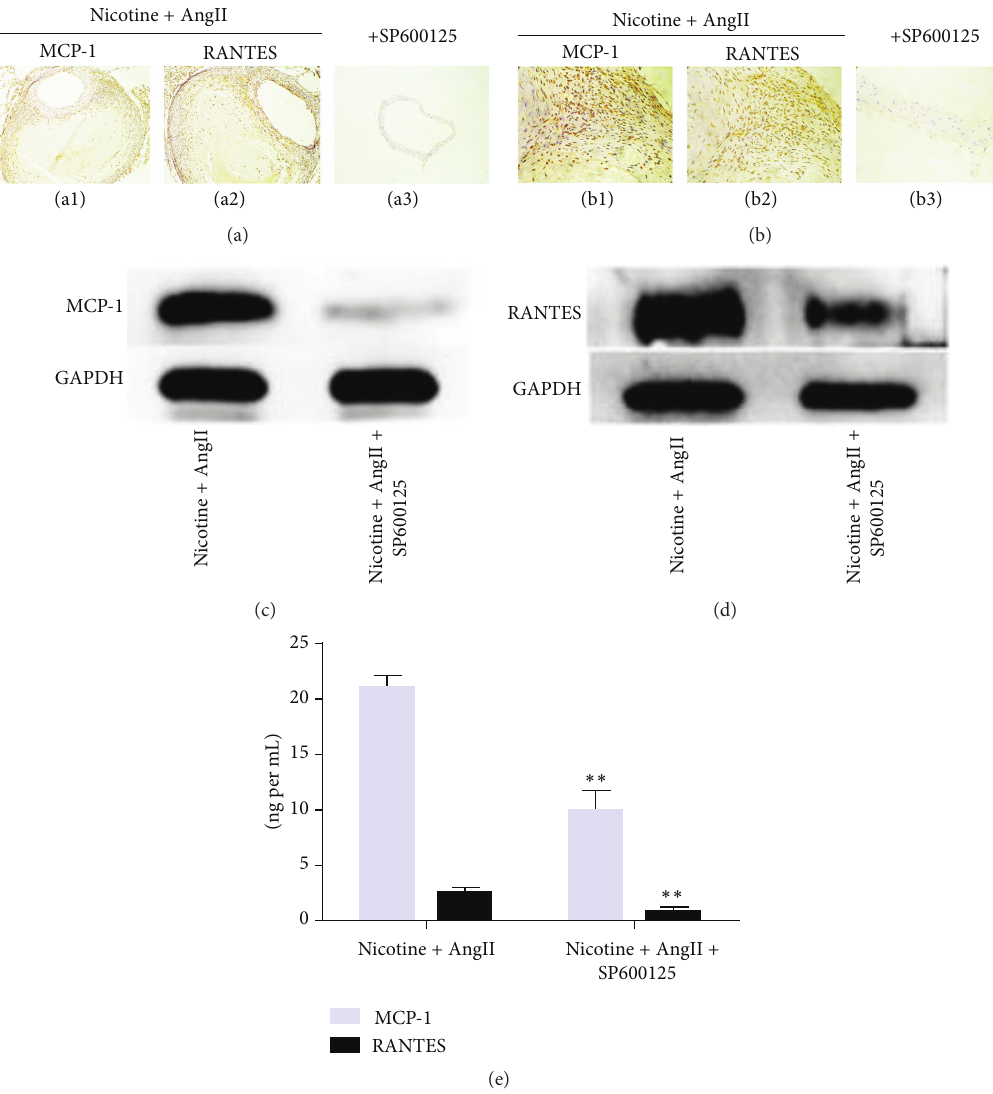
Figure 4: SP600125 suppresses the protein expression of chemokines in aortic tissue. (a) Representative transverse sections of mouse aortic tissue obtained after transient perfusion with nicotine plus AngII, with or without SP600125. MCP-1 and RANTES proteins were undetectable in normal aorta but were abundant in nicotine plus AngII-induced AAA tissues (a1 and a2), where they appear to be expressed in the medial and outer smooth muscle cells. SP600125 inhibited the protein expression of MCP-1 and RANTES in AAA lesions (a3). (c, d) Representative western blots for MCP-1 and RANTES. The band optical density (OD) values (mean ± SD) of MCP-1 and RANTES were evaluated using ImageJ. GAPDH was used as an internal control and results are from independent triplicate experiments. Chemokine expression in the serum as detected by ELISA (e). ∗∗ 𝑃 < 0.01 versus